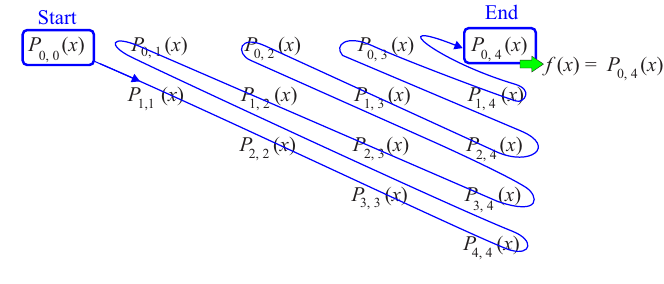
Figure 4. Neville’s